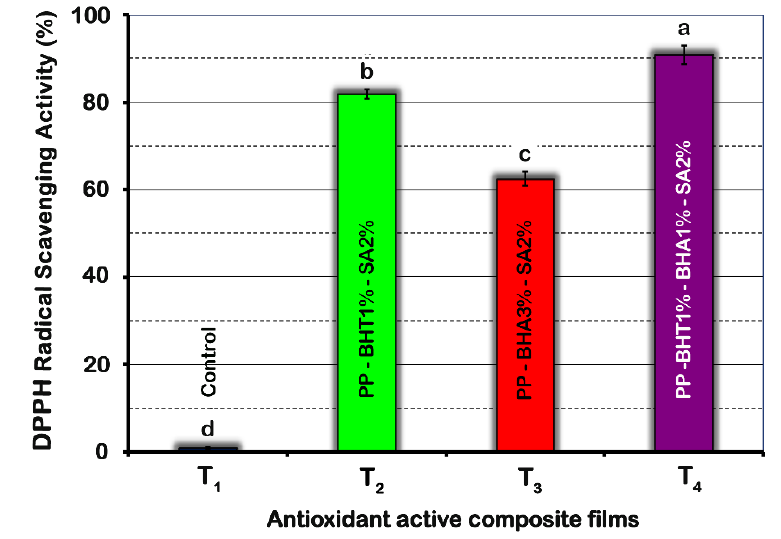
Figure 2. Effect of composition of polypropylene-based films on DPPH radical scavenging activity. Means ( n = 5) with different letters are significantly different ( p < 0.05). Error bars corresponding to standard deviations.